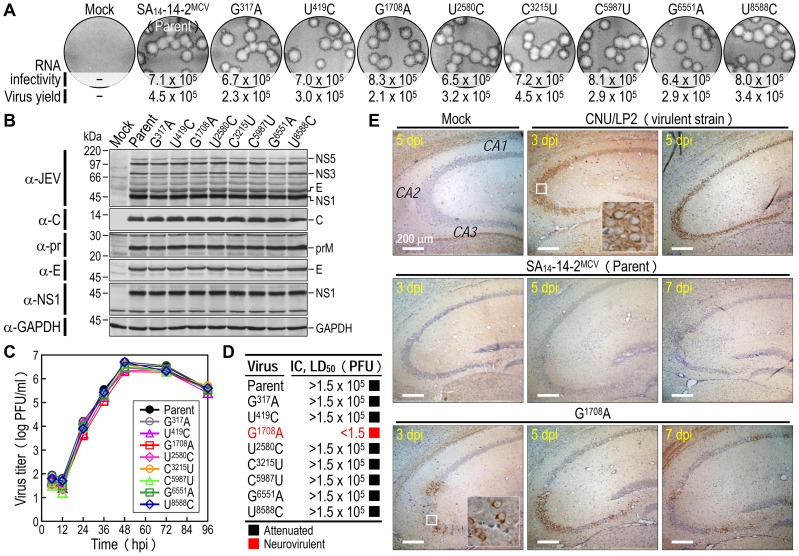
Discovery of a single locus that leads to the reversion of SA14-14-2MCV to lethal neurovirulence.(A-C) In vitro replicability. BHK-21 cells were mock-transfected or transfected with RNAs transcribed from the parent or each mutant cDNA, as indicated. RNA infectivity (in PFU/µg) at 4 dpt was determined by infectious center assay, combined with staining of cell monolayers using an α-JEV antiserum, and virus yield (in PFU/ml) at 22 hpt was measured by plaque titration on BHK-21 cells (A); viral protein accumulation at 18 hpt was examined by immunoblotting of cell lysates with a panel of antibodies as indicated (B). For viral growth analysis, BHK-21 cells were infected at an MOI of 0.1 with the parent or each mutant virus obtained from the corresponding RNA-transfected cells. At the indicated time points, culture supernatants harvested for virus titration on BHK-21 cells (C). (D-E) In vivo neurovirulence. Groups of 3-week-old ICR mice (n = 10 per group) were inoculated IC with doses of the virus stock serially diluted 10-fold, and the LD50 values were determined (D). For immunohistochemical staining, groups of the mice (n = 15 per group) were mock-infected or infected IC with 103 PFU of each virus. At 3, 5, and 7 dpi, five mice were processed for brain section staining with an α-NS1 antiserum. Shown are representative hippocampal slides (E).